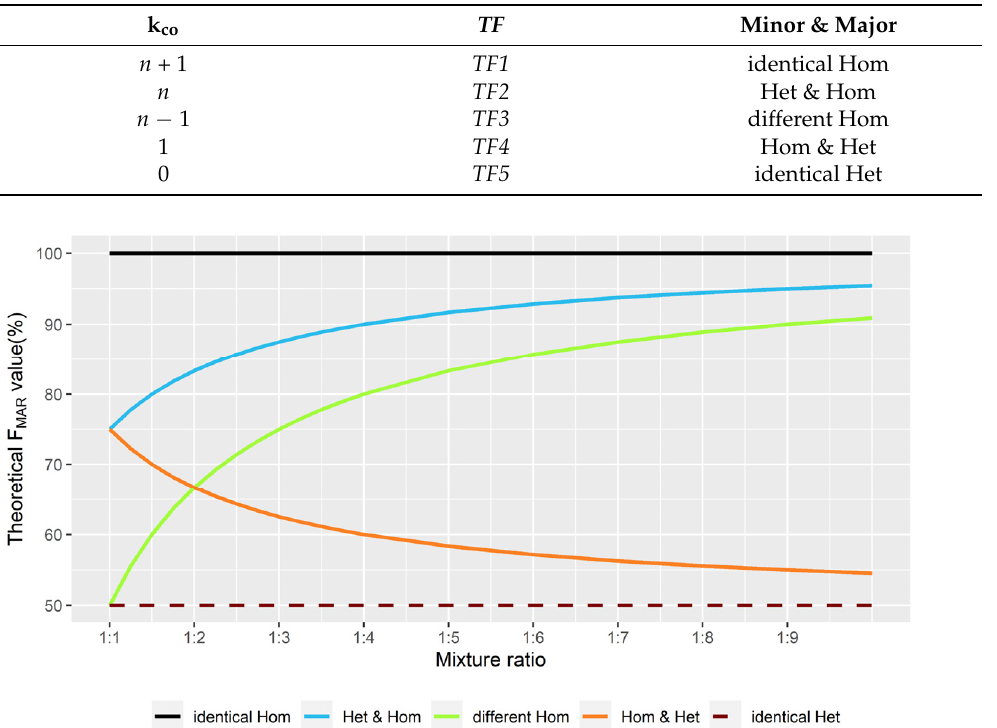
where n is calculated from Equation (2) by taking different values of the coefficient k co into Equation (1). Table 2. Relationship among k co , TF , and the genotype combinations.